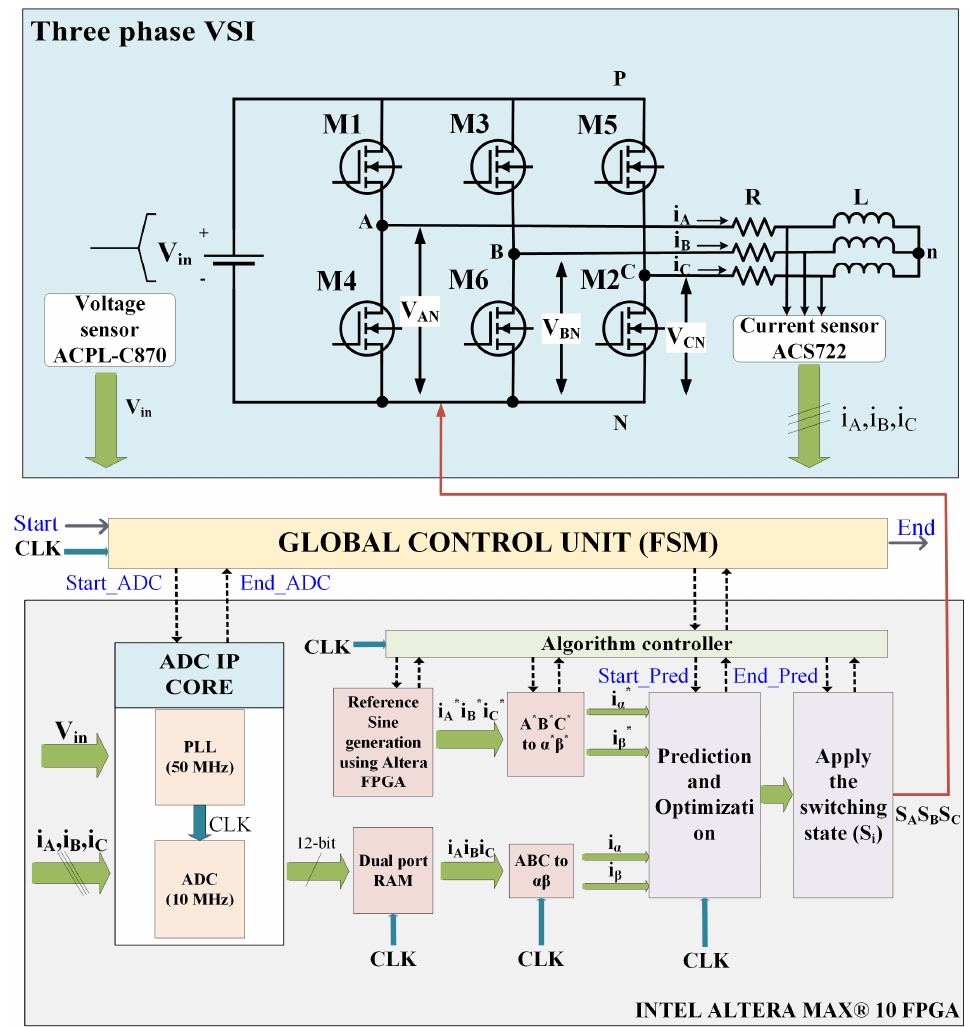
Figure 7. Complete hardware architecture of the FS-PDCC controlled two-level three-phase VSI.